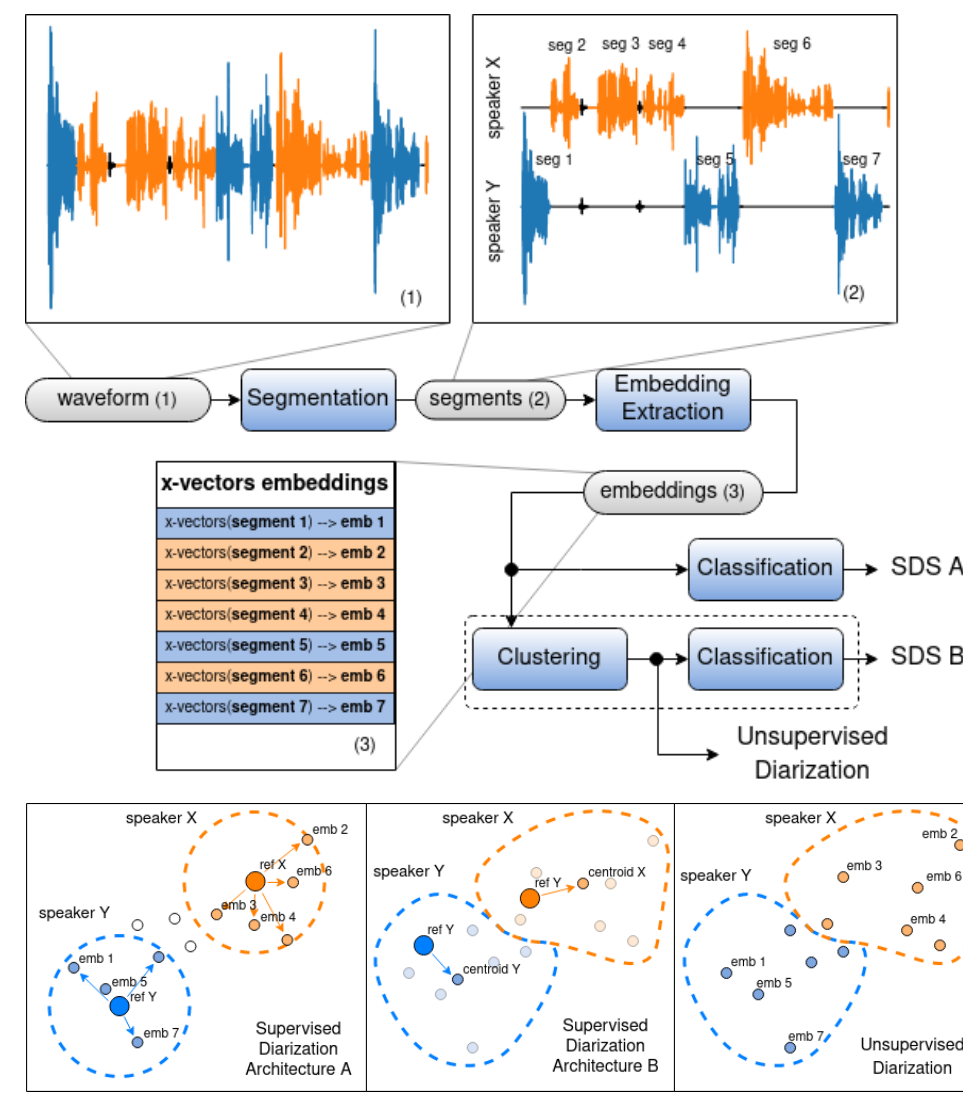
Figure 2. Architectures of the general-purpose diarization systems based on PyAnnote: (Architecture A) identification via separate segments, (Architecture B) identification based on the group (cluster) of segments, and unsupervised segment